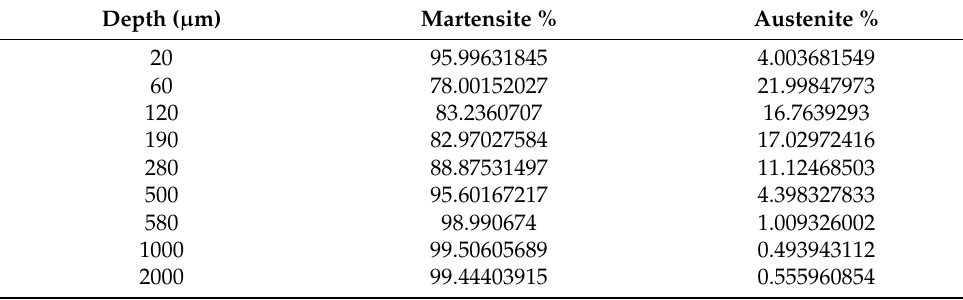
Figure 19. The content of the microstructure from XRD.